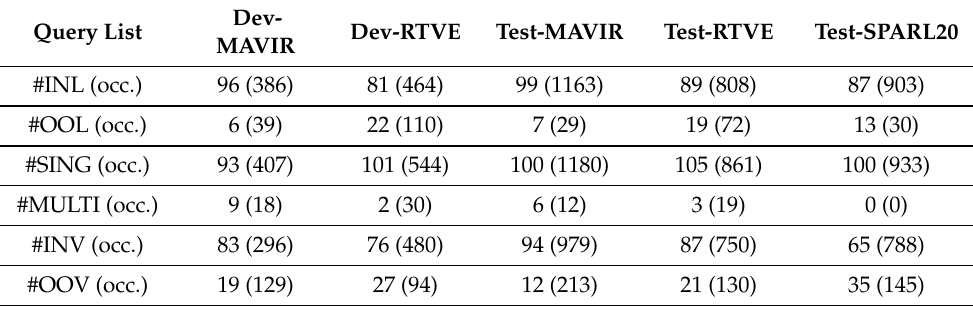
Table 5. Development and test query list characteristics for the MAVIR, RTVE and SPARL20 databases for the QbE STD task. ‘dev’ stands for development, ‘INL’ refers to in-language queries, ‘OOL’ to foreign terms, ‘SING’ to single-word queries, ‘MULTI’ to multi-word queries, ‘INV’ to in-vocabulary queries, ‘OOV’ to out-of-vocabulary queries and ‘occ.’ stands for